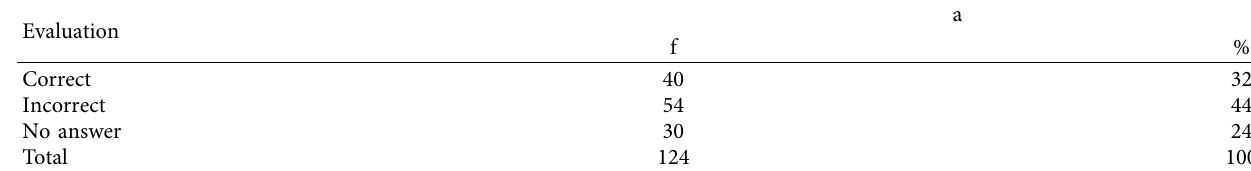
Figure 4: Question Table 8: Distribution of students’ answer to question 4.